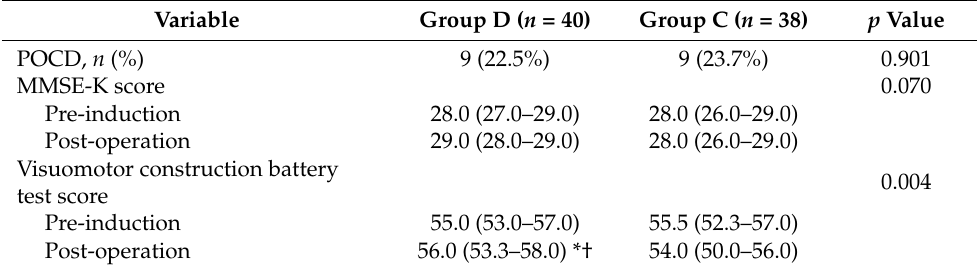
Figure 4. Change in regional oxygen saturation (rSO . Error bars represent standard deviation. * p < 0.05 vs. T0. T0, prior to anesthetic induction; right rSO 2 T1, 10 min after anesthetic induction; T2, 60 min after changing to beach chair position; and T3, 10 min after having returned to a supine position. Among the 78 patients who completed the neurocognitive tests, 18 (23.1%) were di- agnosed with POCD. The incidence of POCD was 9 patients (22.5%) in Group D compared to 9 patients (23.7%) in Group C, which was not significantly different ( p = 0.901). The MMSE-K scores following surgery were comparable between the groups ( p = 0.07). How- ever, the scores of the visuomotor construction battery tests for those in Group D were significantly higher at the postoperative stage than for those in Group C ( p = 0.004) (Table 2).